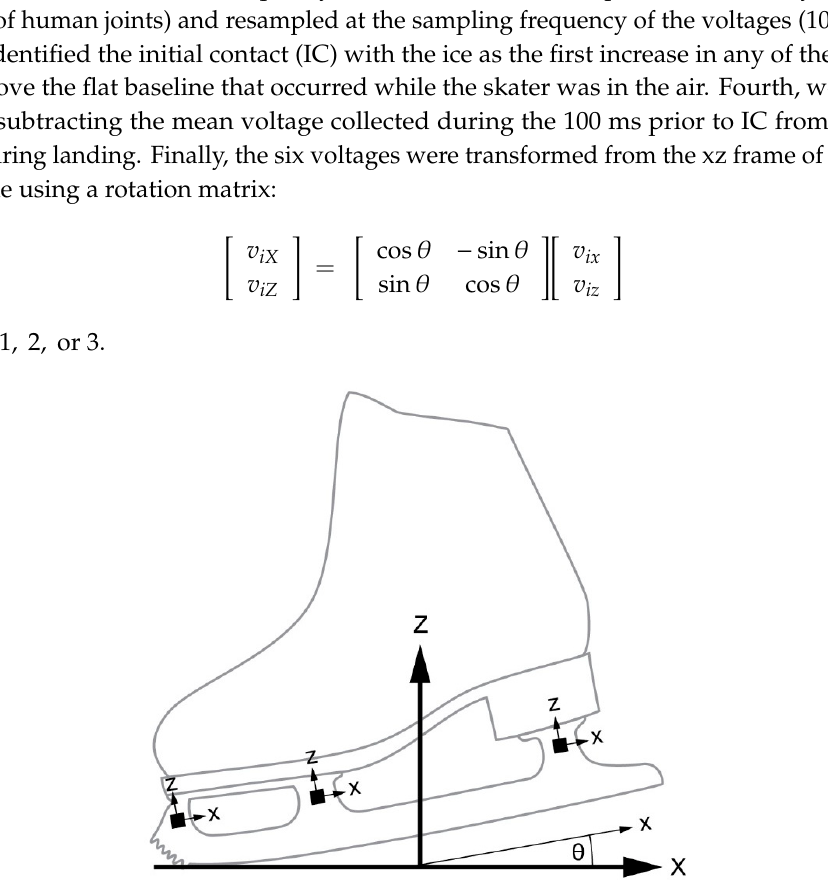
Figure 3. Definition of blade coordinate system (xyz) and intermediate coordinate system (XYZ). The strain gauges (represented as small black squares) were aligned with the blade coordinate system. The intermediate coordinate system is the same as the force plate frame, but rotated about the Z axis so the X axis is in the forward–backward direction of the blade.